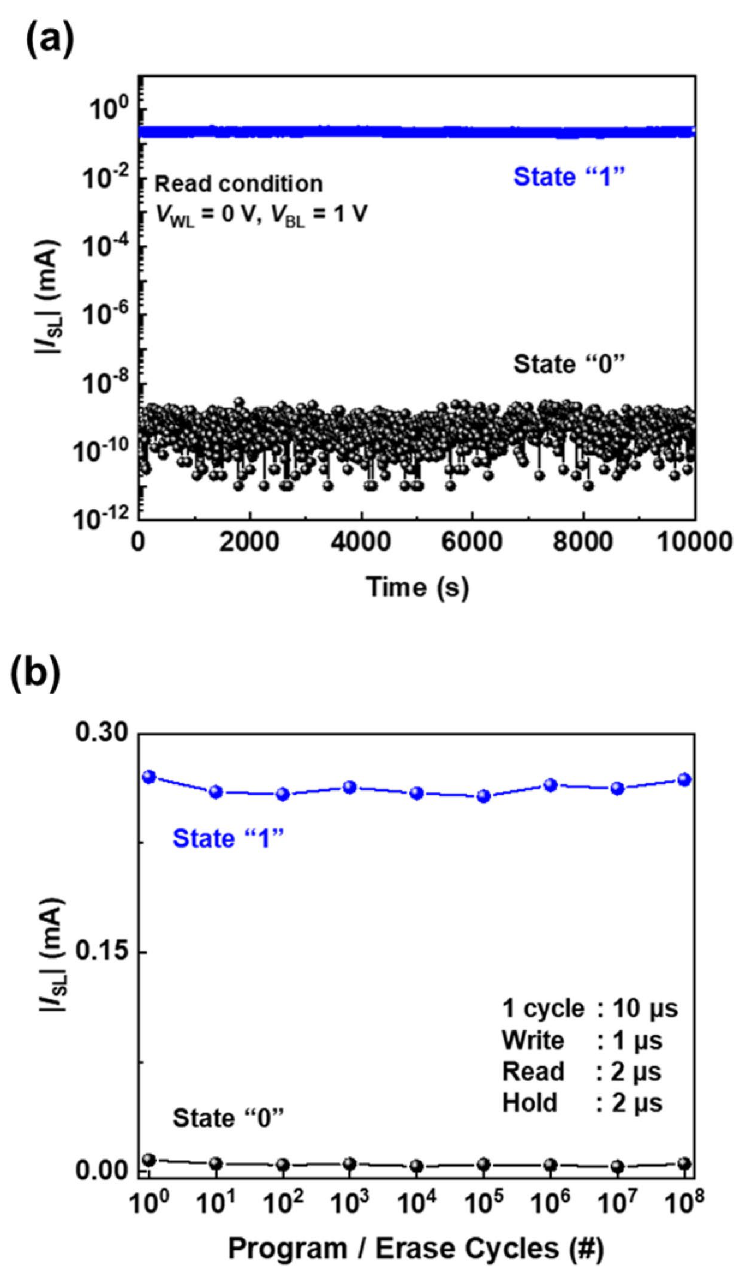
Figure 5. For 1T-SRAM cell: ( a ) nondestructive reading characteristics at V WL = 0.0 V and V BL = 1.0 V and ( b ) endurance